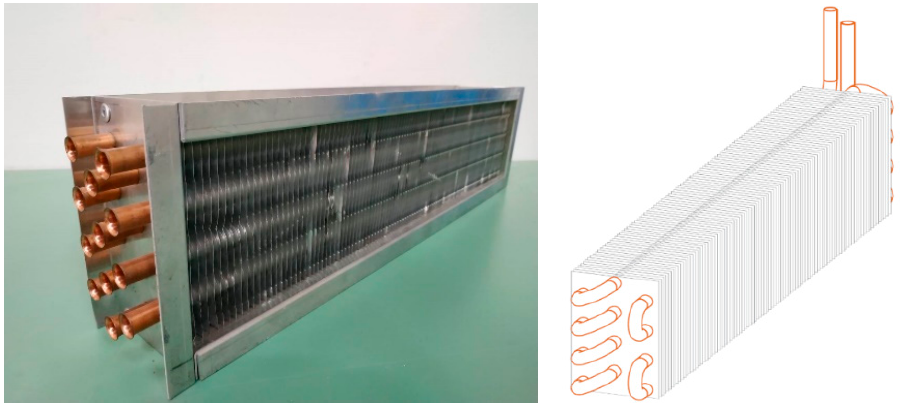
Figure 2. Heat exchanger photo ( left ) and drawing ( right ).